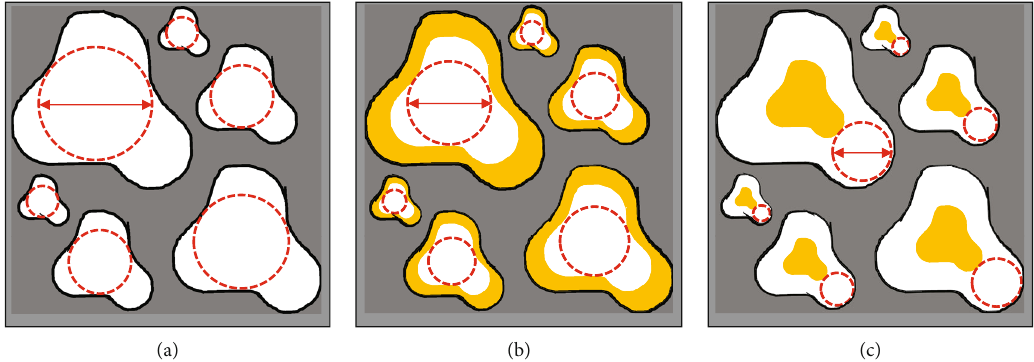
Figure 5: Irregularly shaped pores within hydrate-free and hydrate-bearing porous media. Gray color stands for solid particle, white for fl uid- occupied pores, and yellow for gas hydrates. Red dashed circles represent incircles quantifying fl uid-occupied pores. (a) Irregularly shaped pores with di ff erent sizes in hydrate-free porous media. (b) Irregularly shaped pores in porous media containing grain-coating hydrates. Gas hydrates uniformly grow in all pores with di ff erent sizes, and the shape of fl uid-occupied pores before and after hydrate formation is unchanged. (c) Irregularly shaped pores in porous media containing pore- fi lling hydrates. Gas hydrates uniformly grow in all pores with di ff erent sizes, and the shape of solid hydrates is identical with that of intrinsic pores within porous